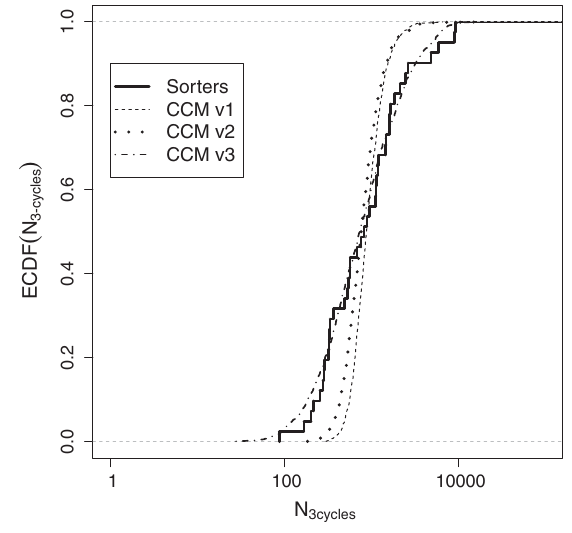
FIG. 10. 3-cycle distributions. Here we see the 3-cycle distri- butions for the different CCMs. The model that fits the best is v3 [Eq. (6)], where the multiple categorization probability is (cid:3) C .